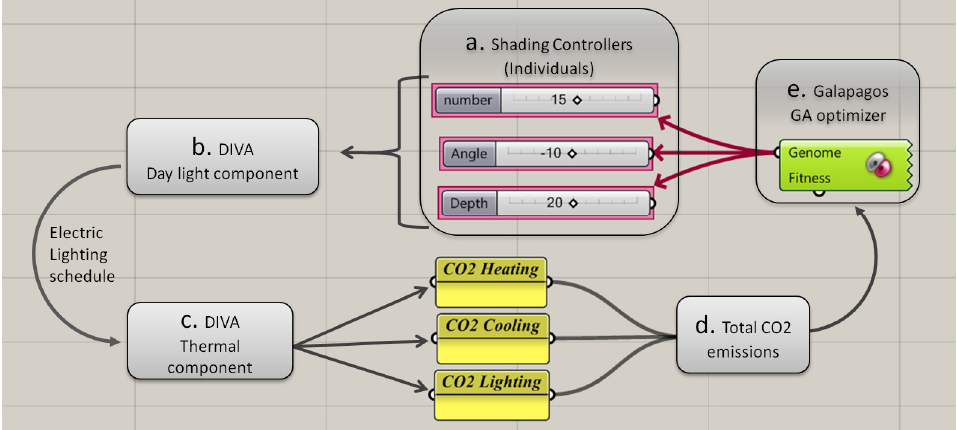
Figure 5. Workflow using DIVA daylight and thermal components, and Galapagos evolutionary